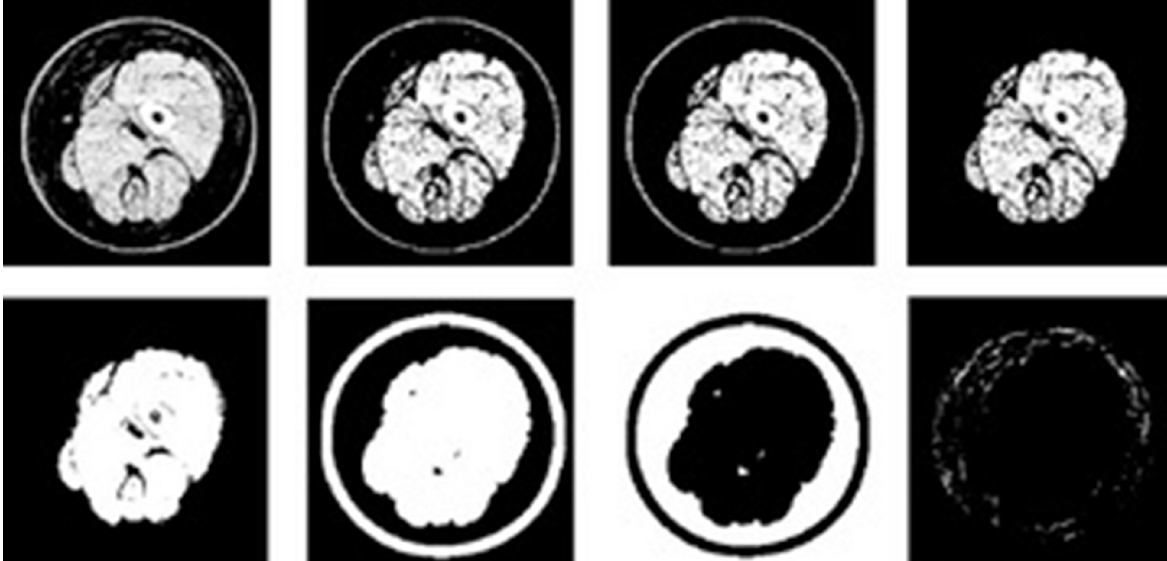
Fig 1. The images under the proposed image processing procedures. The original CT image of the affected limb (the first image; the farthest left one in the upper row), six intermediate images and the final image (farthest right in the lower row) are shown. The algorithm eliminated pixels from -50 Hounsfield unit (HU) to 26 HU (image 2), and removed any remained noise using a simple opening filter and manual reoperation (image 3). The outmost skin was removed based on its location (image 4). The remained pattern was processed as one connected region using the closing filter (image 5). Outside of this one connected region, the eliminated skin line was added as one outside thick line (image 6). This merged morphological pattern was converted by the black-white reversion operation. (image 7). The inversed pattern subtracted from the original CT image yielding a donut-shaped region between the skin and the muscle. (image 8). The nonblack pixels of the final image were regarded as epifascial lymph- proliferative fibrosis.